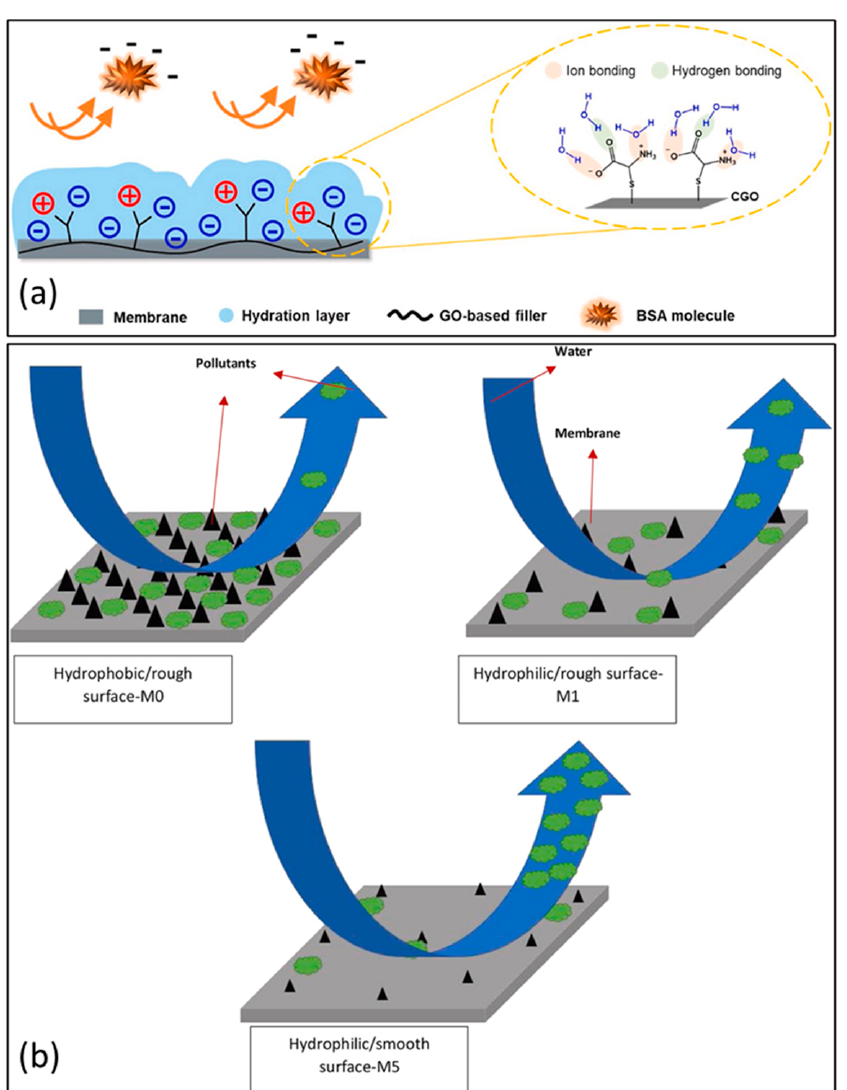
Figure 10. ( a ) Scheme showing that hydrogen and ionic bonding sites can be provided by cysteine- functionalized graphene oxide to the PES membrane to inhibit protein adsorption. Reprinted with permission from [1]. 2020, J. Ind. Eng. Chem. ( b ) the mechanism by which protein fouls the water during the cleaning process. (GO: 1 weight percent; Cs-GO: 1 weight percent, neat PES membrane). Reprinted with permission from [92]. 2018, J. Ind. Eng.